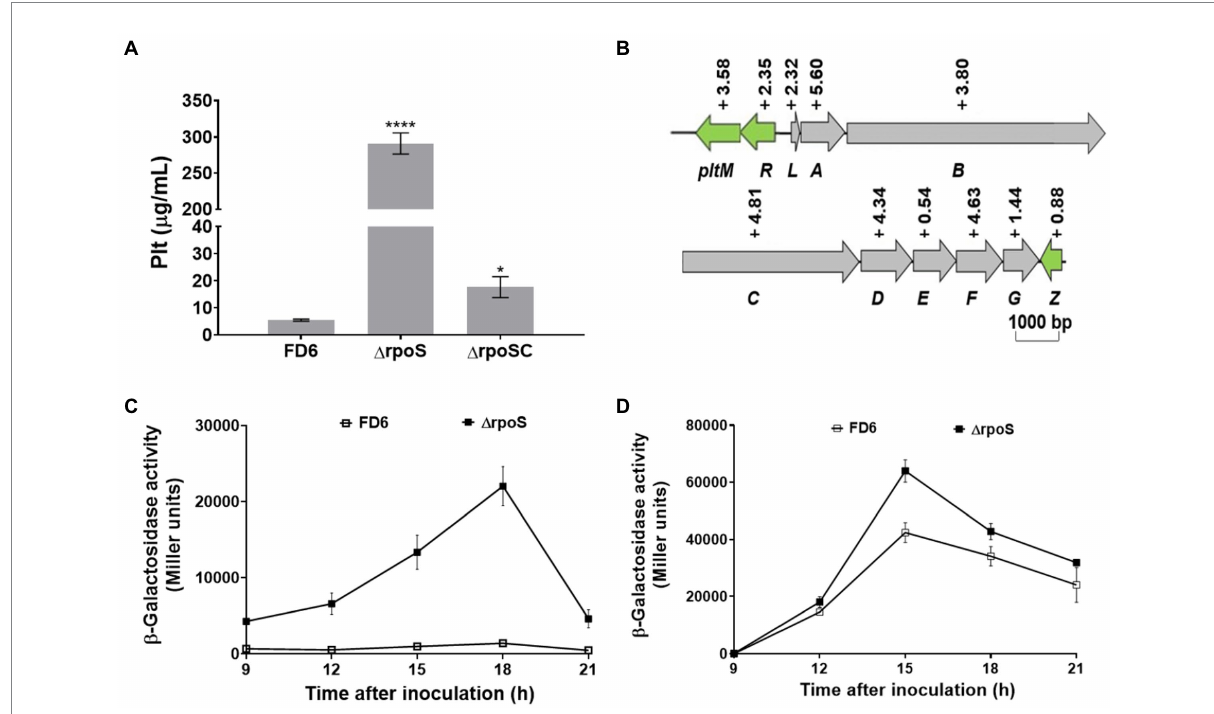
FIGURE 4 Negative regulation of Plt production and the expression of gene cluster by RpoS. (A) HPLC analysis of Plt biosynthesis by FD6 and its derivatives. (B) Influence of RpoS on the transcript level of the Plt biosynthesis gene cluster in Pseudomonas protegens FD6. Gray and green indicate the same meanings. (C,D) Deletion of rpoS markedly increased the expression of the pltL-lacZ and pltL ′ - ′ lacZ fusions. Error bars represent the standard deviation of the mean. * p < 0.05, and **** p < 0.0001.